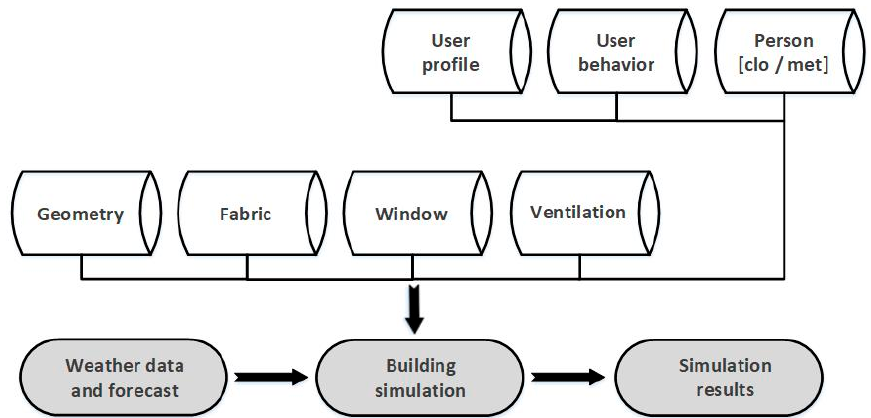
Figure 2. Database set-up of the German model who extended the current Heat-Health Warning System (HHWS) with a thermal building simulation model, modified on the basis of [73].